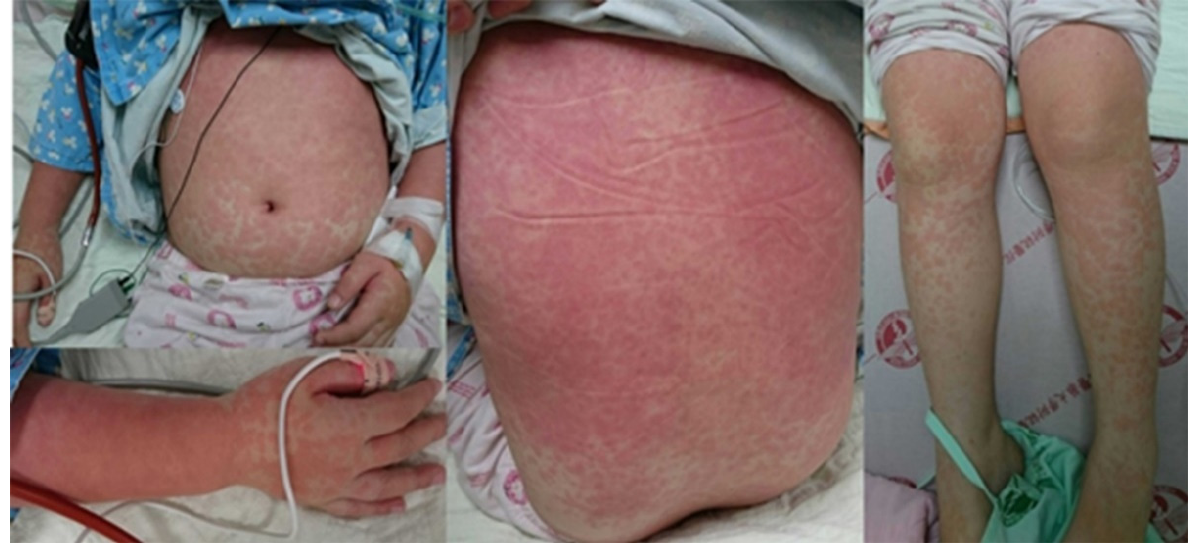
Figure 1. Scattered red maculopapular rash on the trunk and limbs, partially pressed to fade and partially fused into patches.